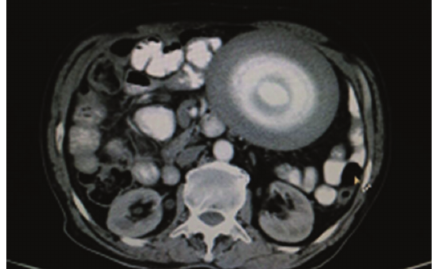
Figure 1: Contrast CT abdomen showing concentrically calcified mass.